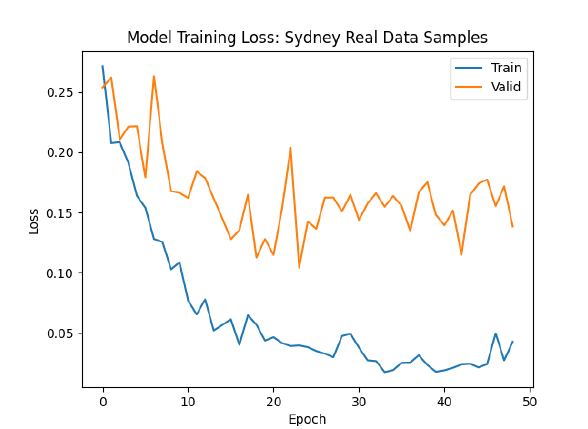
Figure 4. Training curves for the baseline model trained with real samples from Sydney dataset